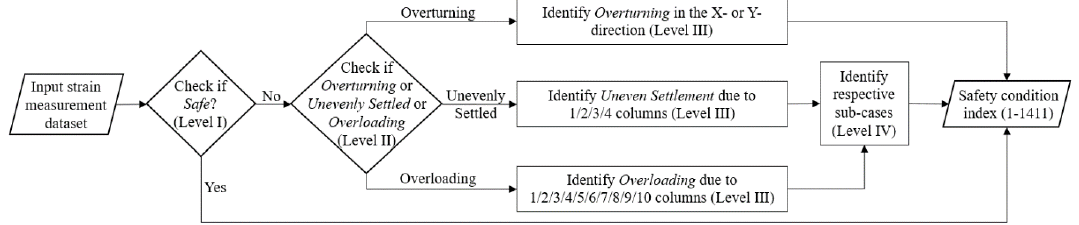
Figure 4. Prediction model flowchart.